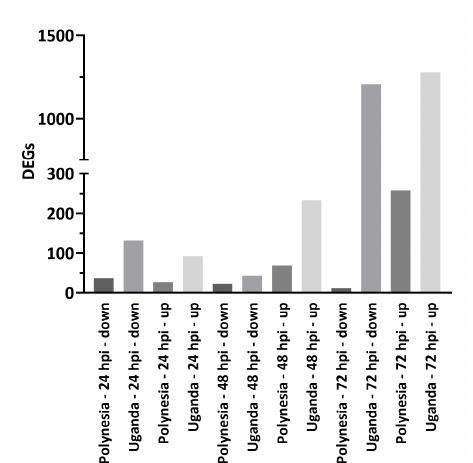
Figure 1. Differentially expressed genes (DEGs). Number of ≥ two-fold that were significant ( p -value ≤ 0.05) and differentially expressed genes at 24, 48 and 72 h post infection with ZIKV Polynesia and ZIKV Uganda.